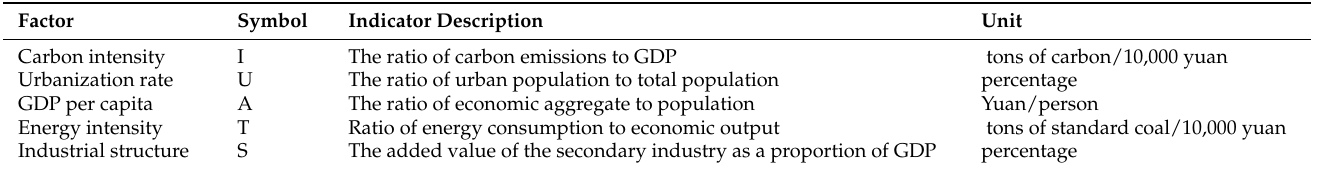
Table 4. The established indicators for variables of the STIRPAT